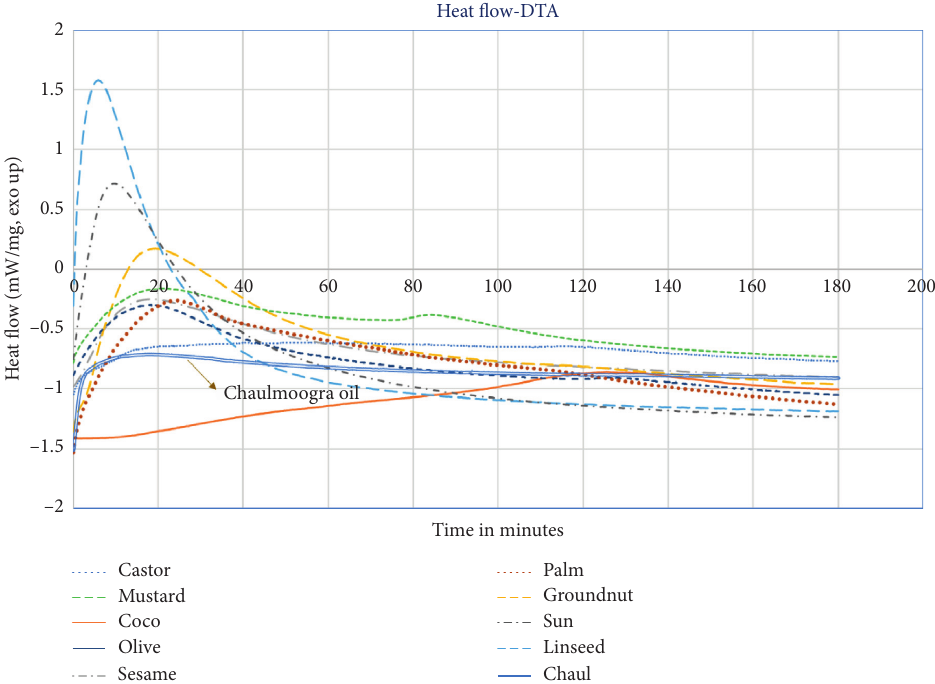
Figure 23: Isothermal DTA of different oils in